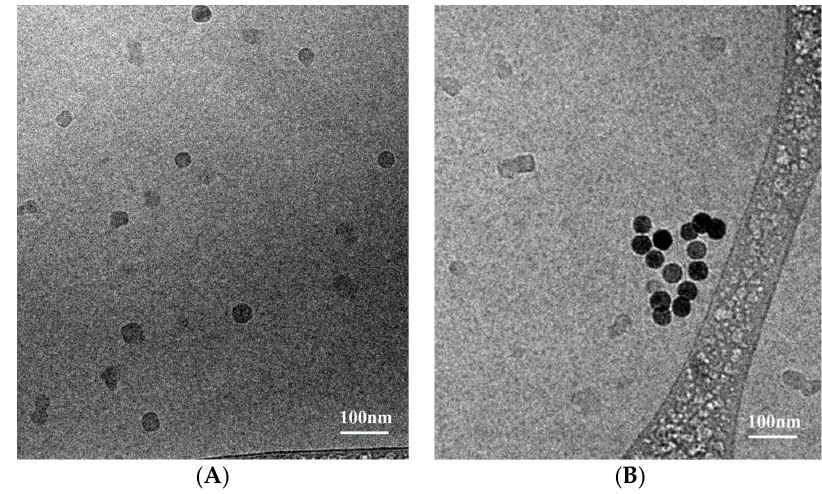
Figure 4. Cryo-TEM images of ( A ) hollow P(RGD) and ( B ) P(RGD)/Pal,Alp NCs.